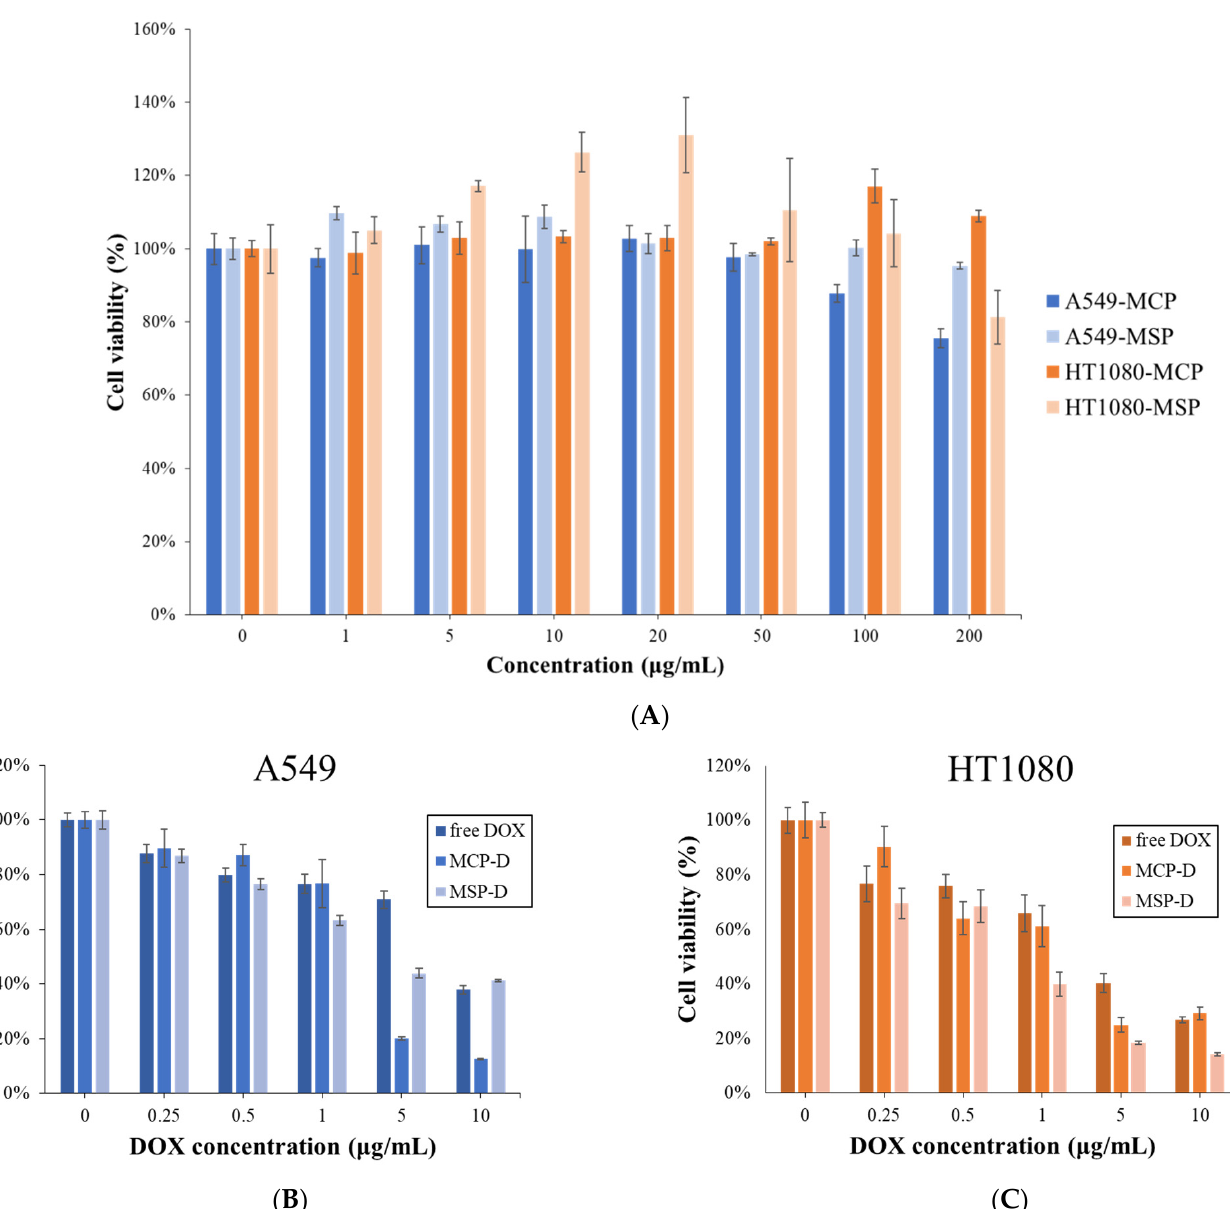
Figure 5. Relative cell viabilities of A549 cells and HT1080 cells exposed to MCP 50 and MSP 50 at various concentrations ( A ); cytotoxicity of A549 cells ( B ), and HT1080 cells ( C ) exposed to free doxorubicin (DOX) and DOX-loaded MCP 50 (MCP-D) and DOX-loaded MSP 50 (MSP-D) micelles at various DOX concentrations.